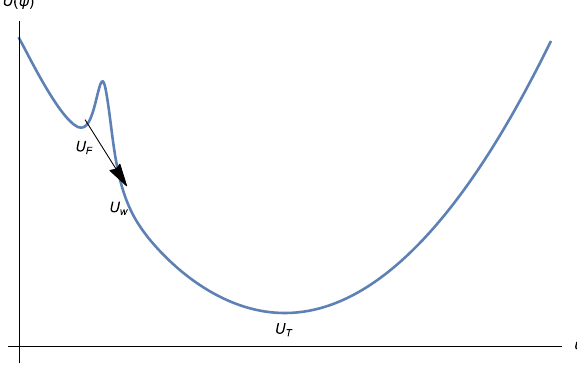
Fig. 2 Scalar field potential U (ψ) . Here U F = U (ψ F ) and U T =